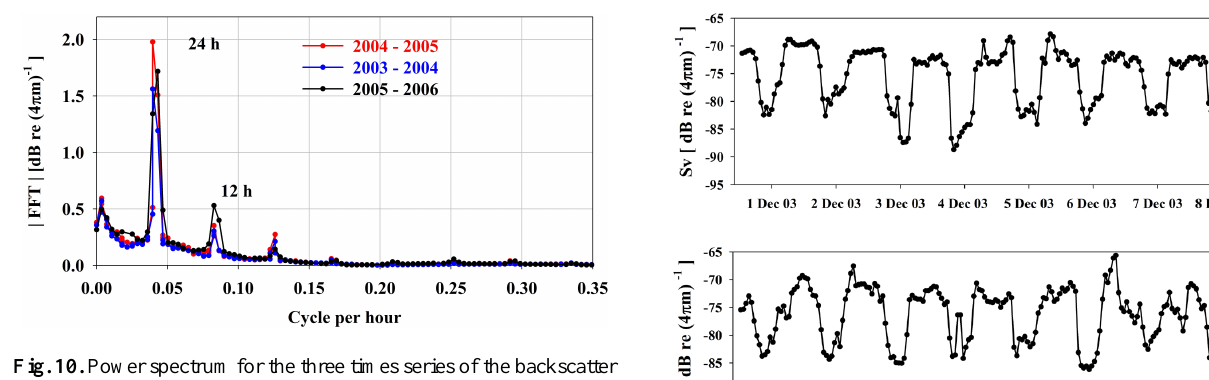
Fig. 10. Power spectrum for the three times series of the backscatter strength at 40m depth.